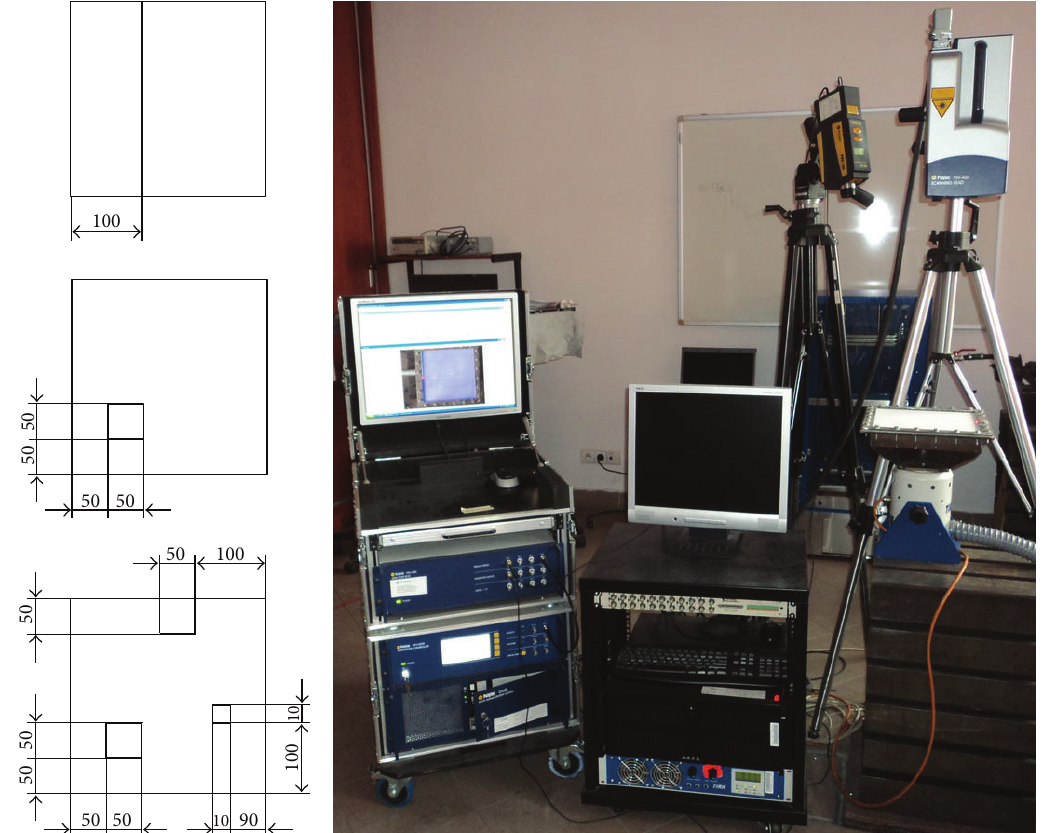
Figure 2: Schemes of surface damage of tested plates and experimental